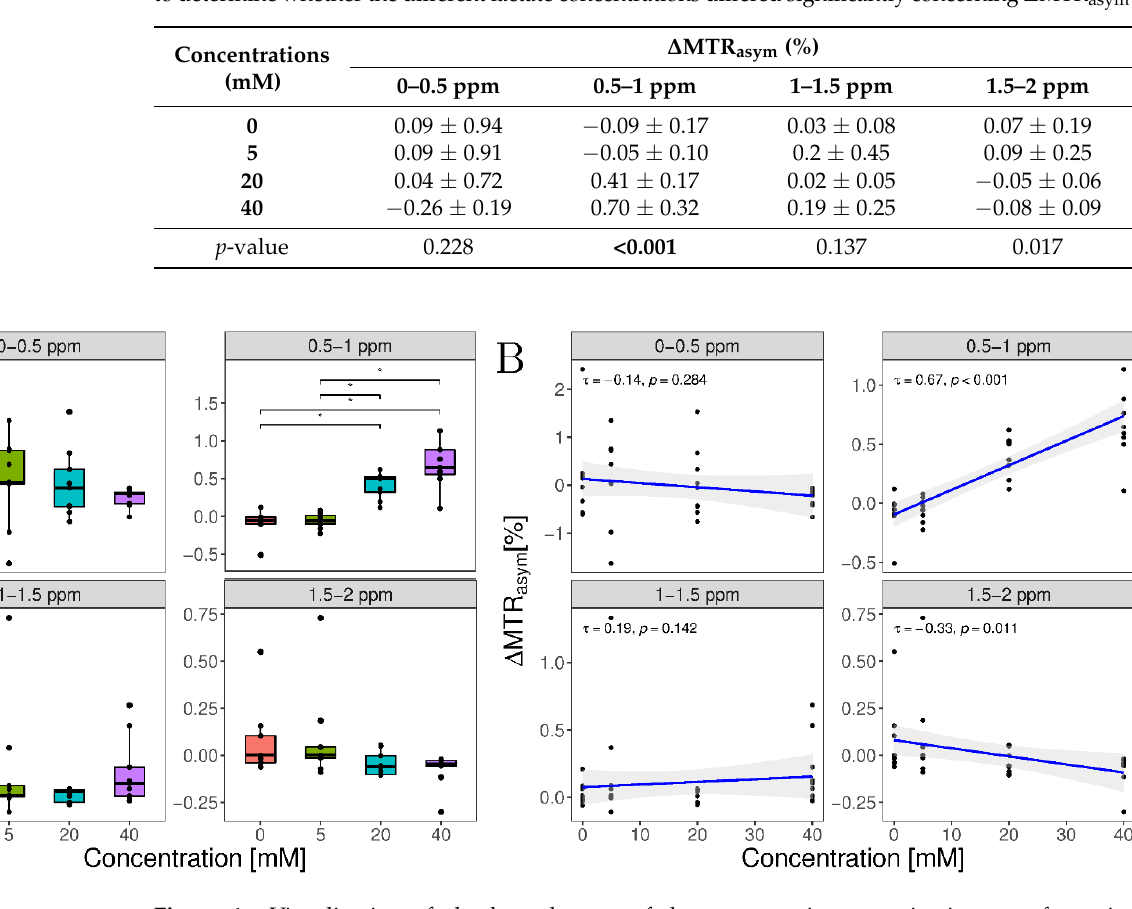
Figure 4. Visualization of absolute changes of the asymmetric magnetization transfer ratios ( ∆ MTR asym ) as a function of injected lactate concentrations as ( A ) box plots and ( B ) scatter plots with correlations. ( A ) Boxplots of ∆ MTR asym values as a function of systematically varied assessment ranges. Thick lines indicate medians, while box outlines indicate the upper (75th percentile, Q 3 ) and lower quartiles (25th percentile, Q 1 ), and whiskers with a maximum width of 1.5 Interquartile range (IQR = Q 3 – Q 1 ). All other observed points are plotted as outliers. Significant differences are marked by asterisks (*) ( B ) Correlations between ΔMTR asym and injected lactate concentrations as function of systematically varied assessment ranges. Table 3. Absolute changes of the asymmetry magnetization transfer ratio (ΔMTR asym ) values under various lactate concentrations in situ. Absolute changes were determined by relating the post-injec- tion ΔMTR asym values to the pre- injection ΔMTR asym values. The non-parametric Friedman test was used to determine whether the different lactate concentrations differed significantly concerning Δ MTR asym .